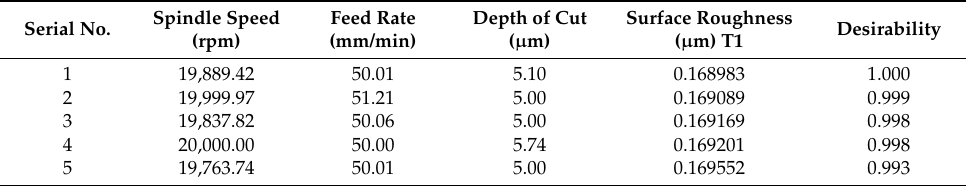
Table 7. Optimization results for the surface roughness using the diameter of tool T1 (200 µ